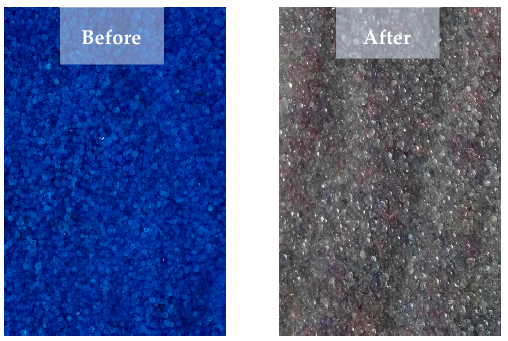
Figure 6. Experimental setup photograph: ( a ) absorption process during the night; ( b ) regeneration process during day and ( c ) Mini meteorological station.